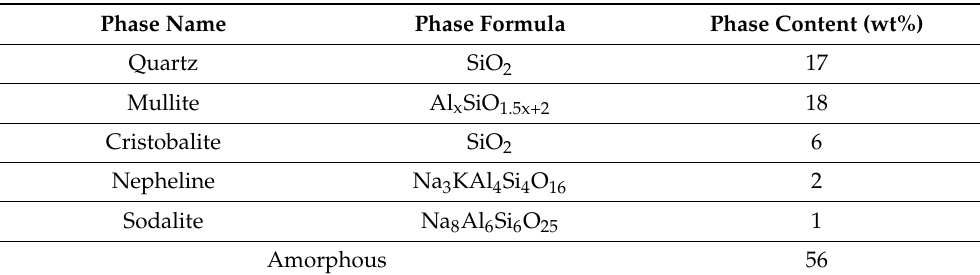
Figure 1. X-ray diffractogram of the spent pot lining aluminosilicates. Table 4. Phase composition of the spent pot lining aluminosilicates determined using Rietveld analysis after XRD